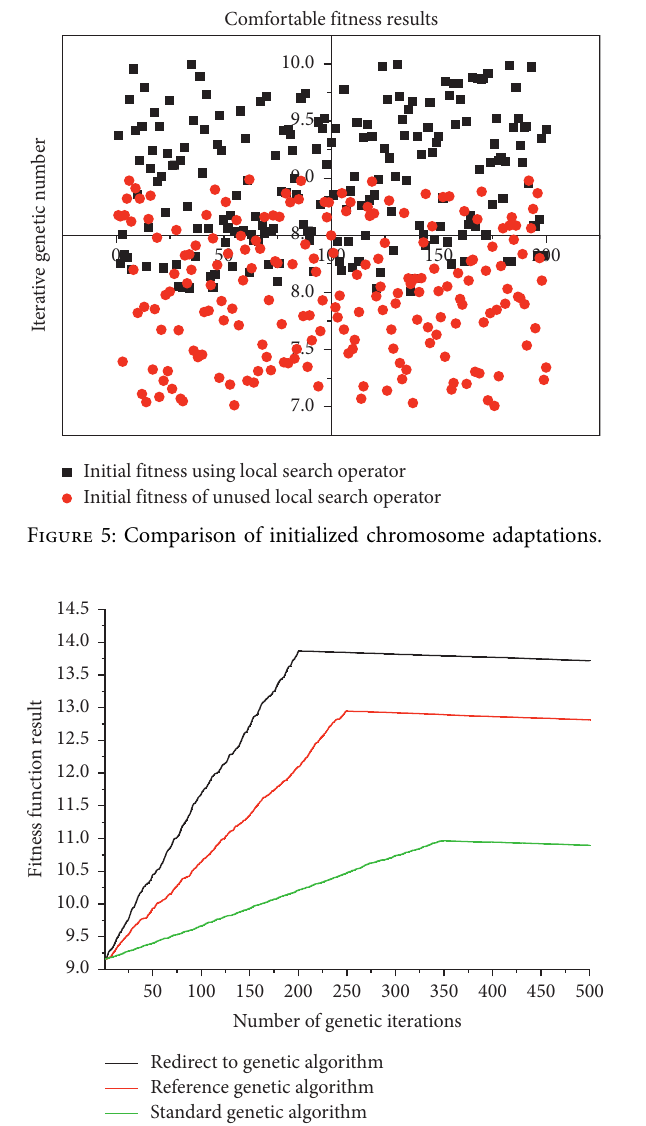
Figure 6: Plot of the values of the fitness function for the three genetic algorithms.